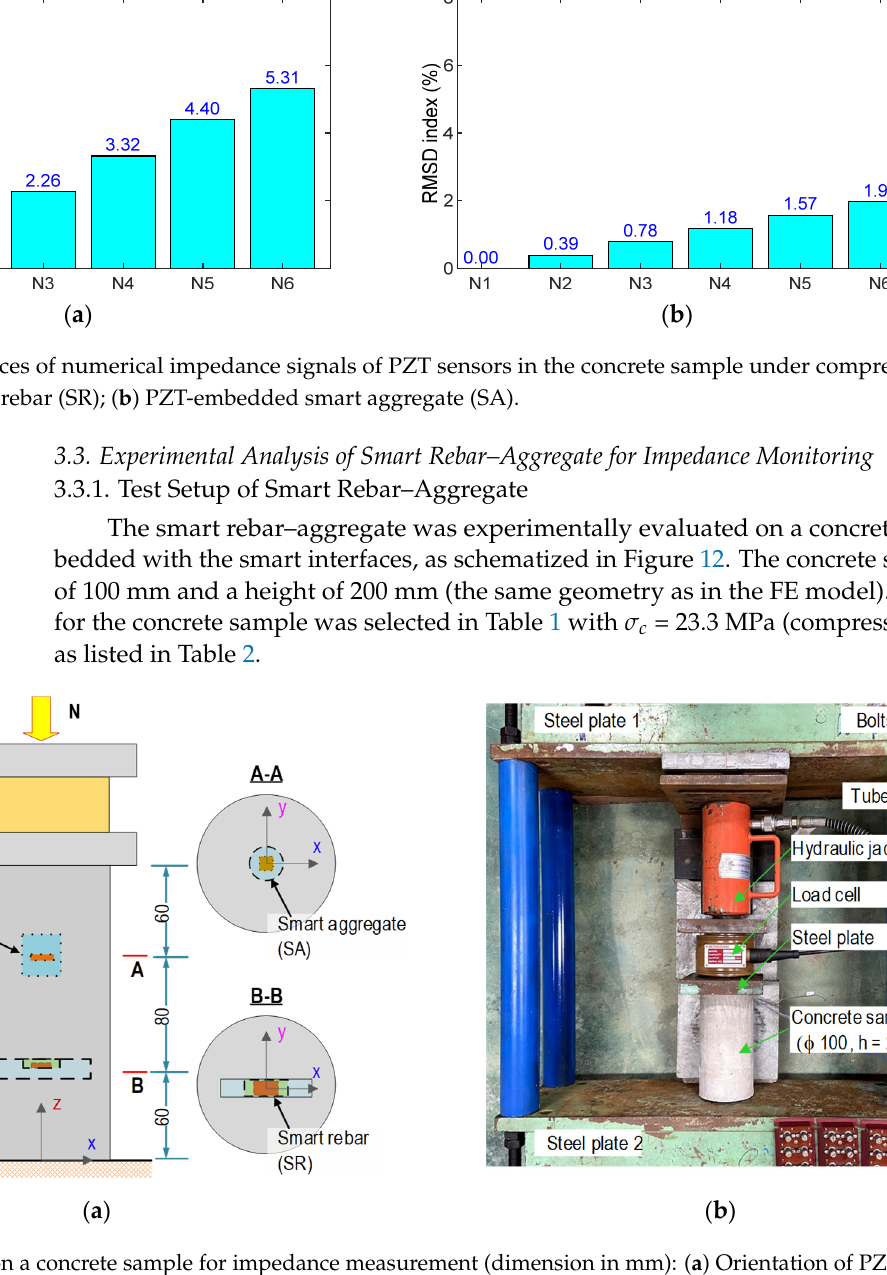
Figure 12. Test setup on a concrete sample for impedance measurement (dimension in mm): ( a ) Orientation of PZT sensors; ( b ) Concrete sample on a test structure.